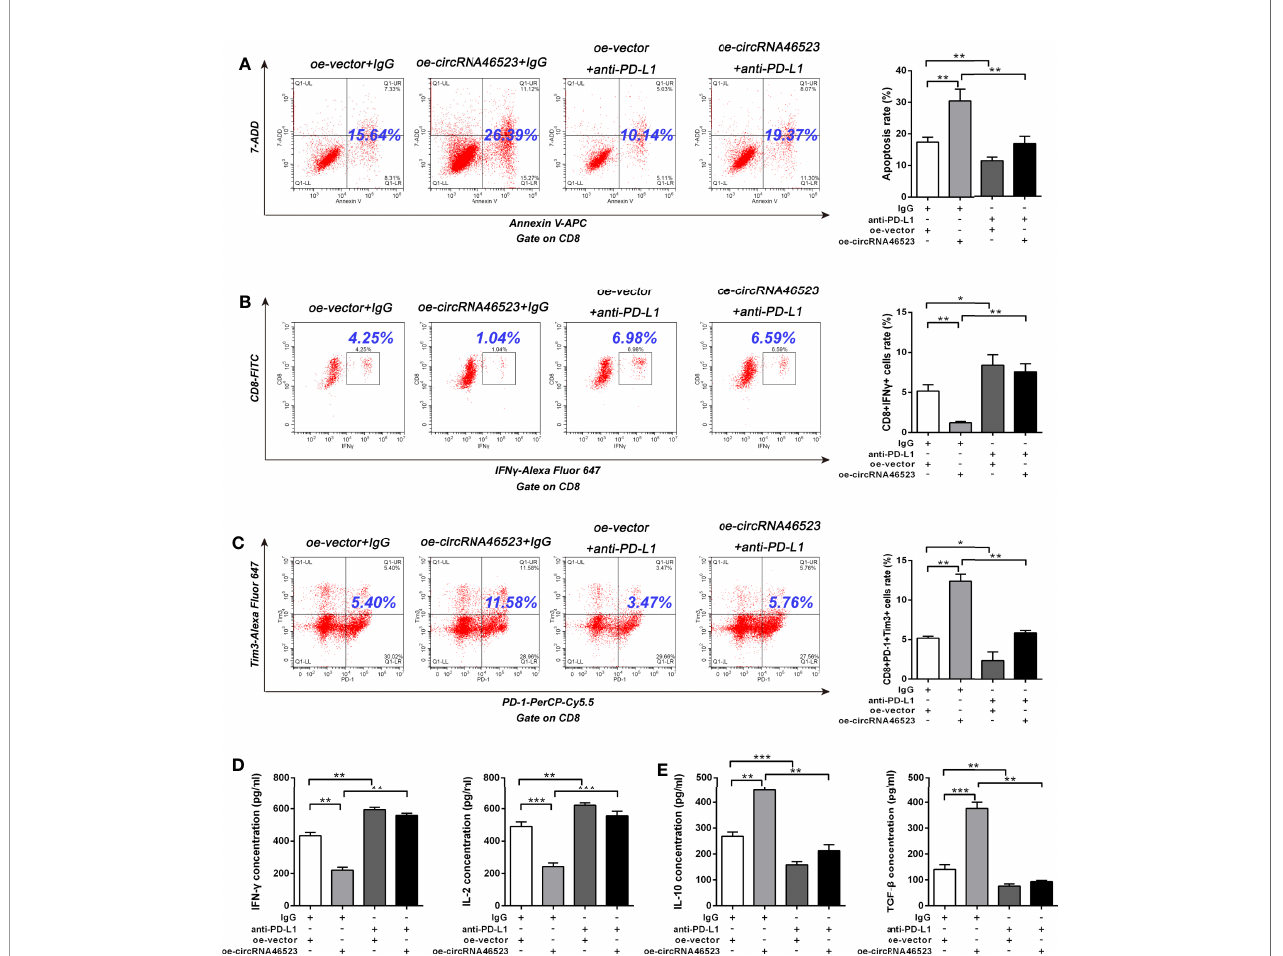
FIGURE 7 | Hsa_circ_0046523 regulated the apoptosis, function and exhaustion of CD8 + T cells, and the expression of immunoregulatory cytokines via PD-L1. PC cells with hsa_circ_0046523 overexpression were co-cultured with PBMCs, and PD-L1 neutralizing antibody (anti-PD-L1) was added to the co-culture system. (A – C) Flow cytometry analysis of apoptosis, function and exhaustion of CD8 + T cells in PBMCs after co-culture. (D, E) ELISA analysis of the levels of the immune effect cytokines IFN- g and IL-2, and immunosuppressive cytokines IL-10 and TGF- b in the supernatant of PBMC cells after co-culture. Data were expressed as means ± SD of three independent experiments. * P < 0.05, ** P < 0.01, *** P <